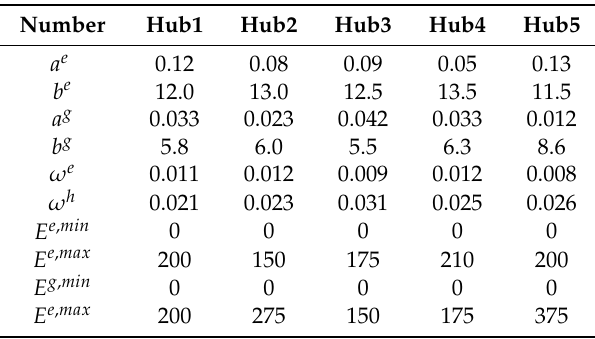
Figure 3. Structure of multiple energy hub system. Table 1. Parameters of the test system.